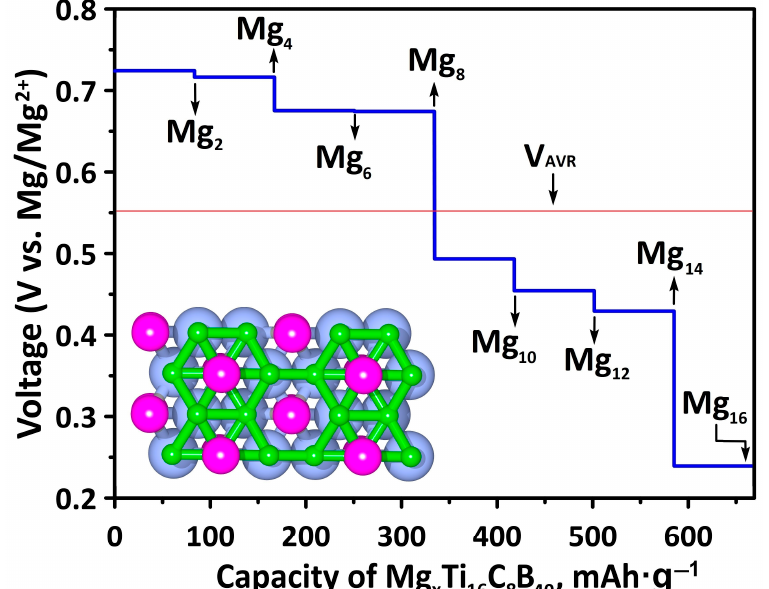
Figure 5. Open-circuit voltage curve of composite material Mg X Ti 16 C 8 B 40.